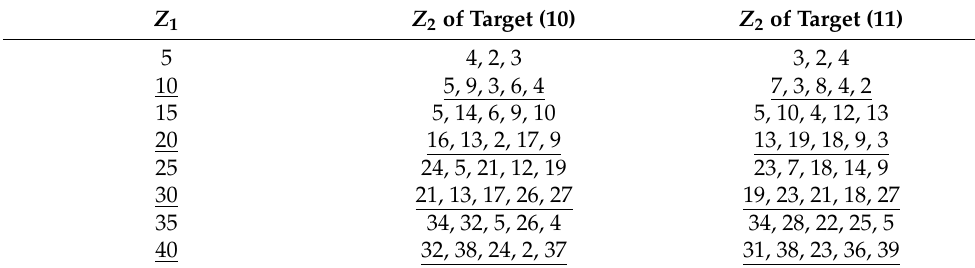
Table 5. Low-noise pole-slot numbers scheme for p = 1.